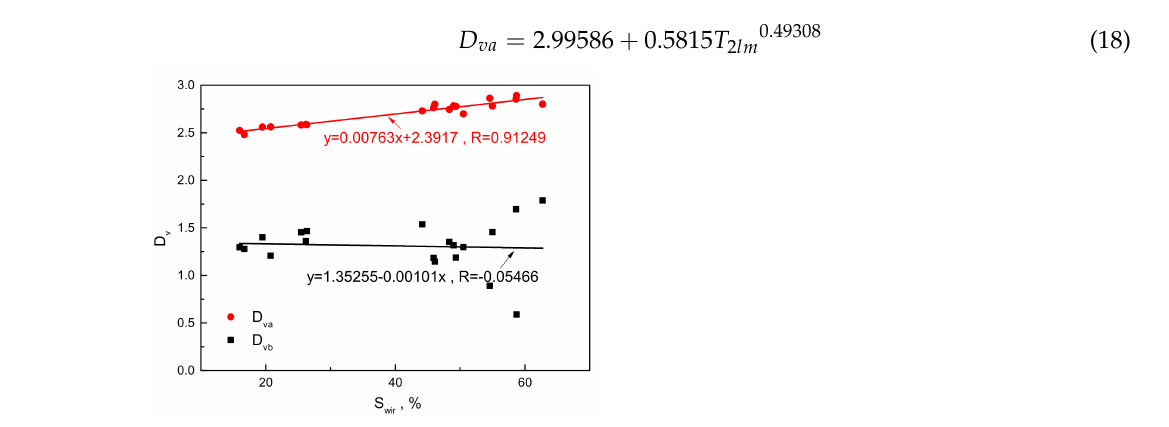
Figure 10. D v —Swir relationship ( D va , Swir) and ( D vb , Swir) are marked by red spot and black square, respectively.